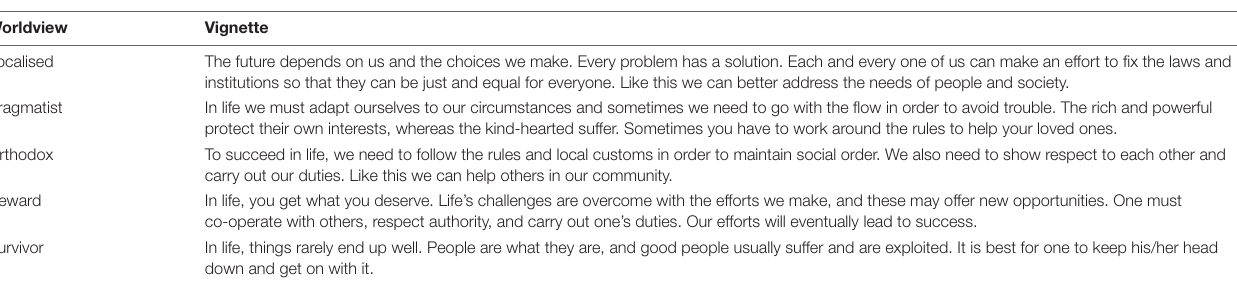
TABLE 2 | Worldview